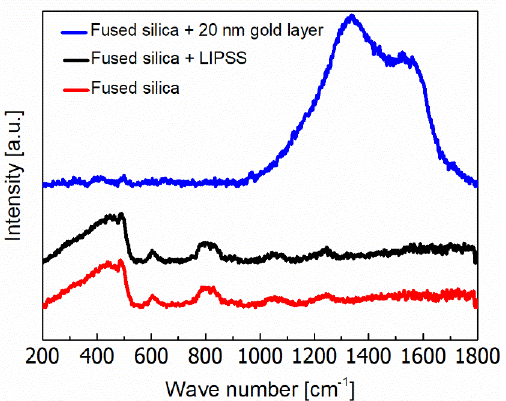
Figure 6. Raman spectrum of the initial, non-irradiated fused silica surface in comparison to fused silica surfaces covered with a thin gold layer before and after the formation of HSFL by fs-laser irradiation ( v = 0.15 m / s, F = 4.5 J / cm 2 , ∆ x = 4 µ m) using a 20 nm thin gold layer. The spectra of initial fused silica and fused silica with LIPSS are magnified by a factor of 3.